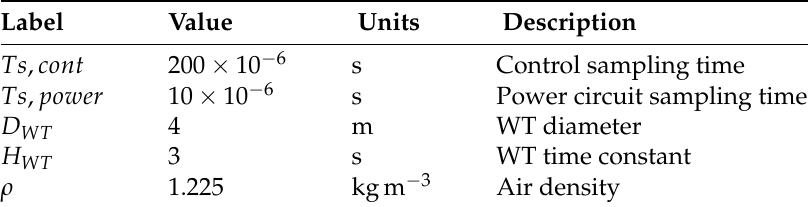
Table 5. Simulation parameters. WT: wind turbine.